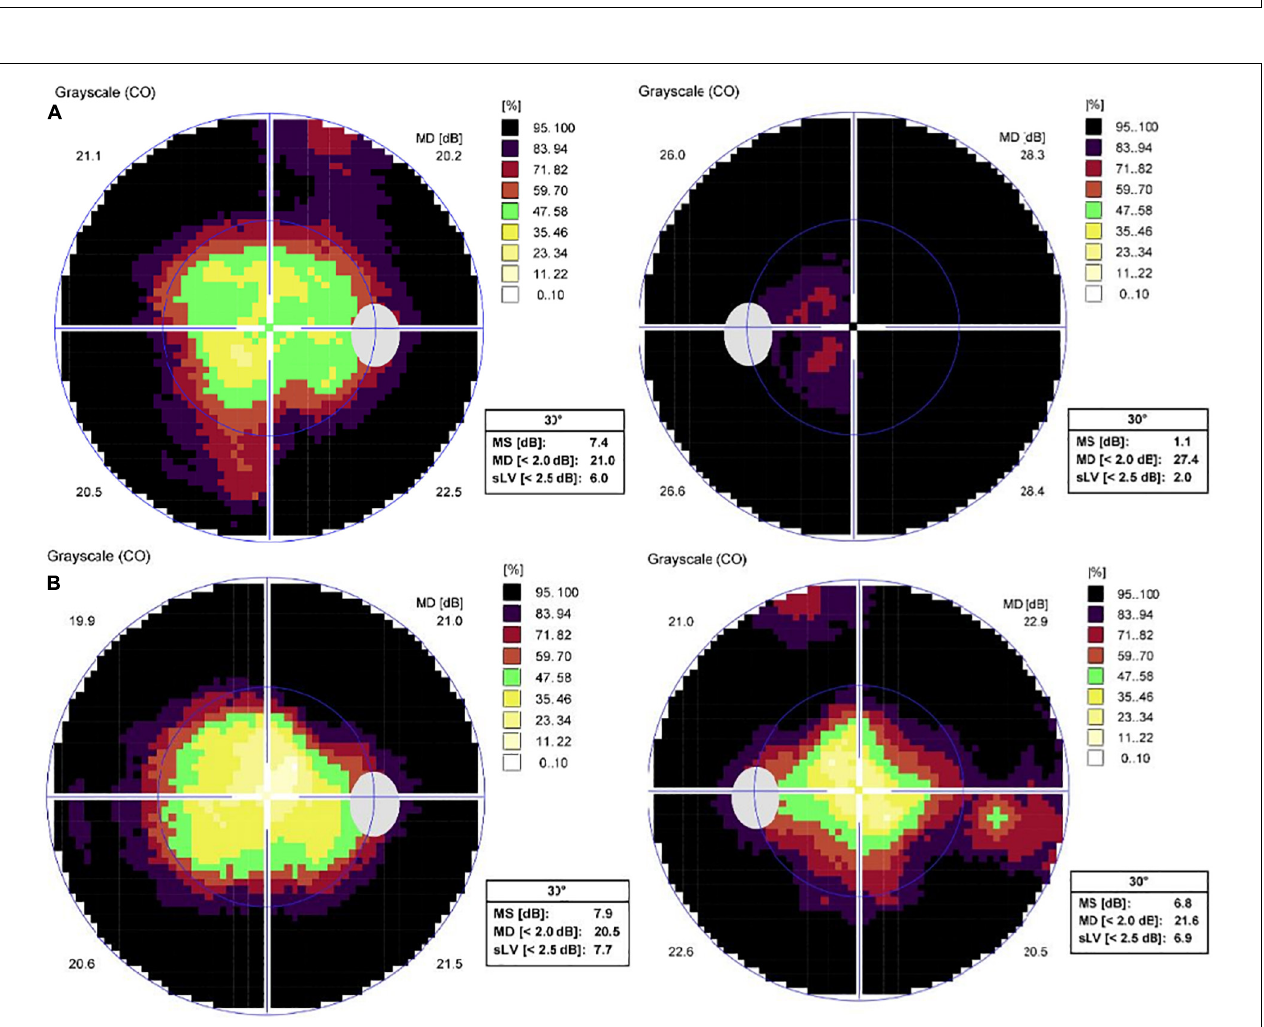
FIGURE 3 | Standard automated perimetry test results of both eyes. (A) Peripheral visual field defects of both eyes at the initial examination. (B) One month after intravitreal aflibercept in the left eye, visual field of the left eye improved.